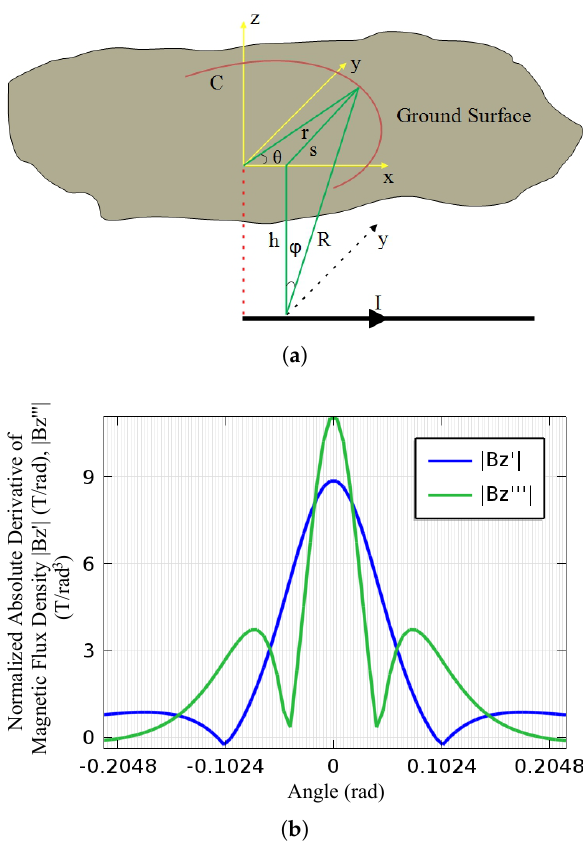
Figure 6. ( a ) Single current carrying conductor model: Conductor of finite length along x-axis carrying current I and buried at a depth h below the surface in a mono-layer soil of permeability µ , derivative of magnetic flux density is taken at the surface of earth on the circle C. ( b ) 1st and 3rd order circular derivative of magnetic flux density: the position of the main peak is at 0 rad which represents the orientation of buried conductor. Main peak (cid:48)(cid:48)(cid:48) width of B is considerably less than the main peak width of B z (cid:48) is greater than B z